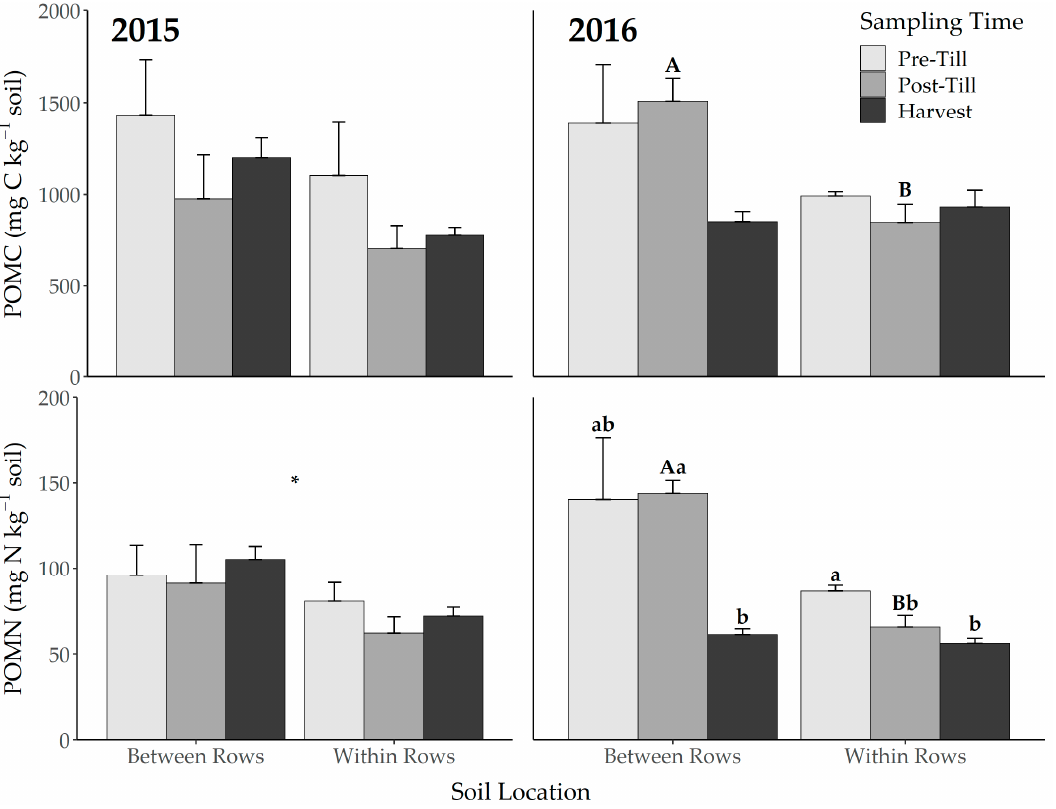
Figure 3. Effect of soil location and sampling time on particulate organic matter carbon and nitrogen (POMC and POMN, respectively) in 2015 and 2016. Error bars represent one standard error. Asterisks represent a difference between soil locations across time points ( p < 0.05). Different capital letters over bars represent a significant difference between soil locations within time point ( p < 0.01), while different lowercase letters over bars represent a significant difference between sampling times within soil locations ( p < 0.1).